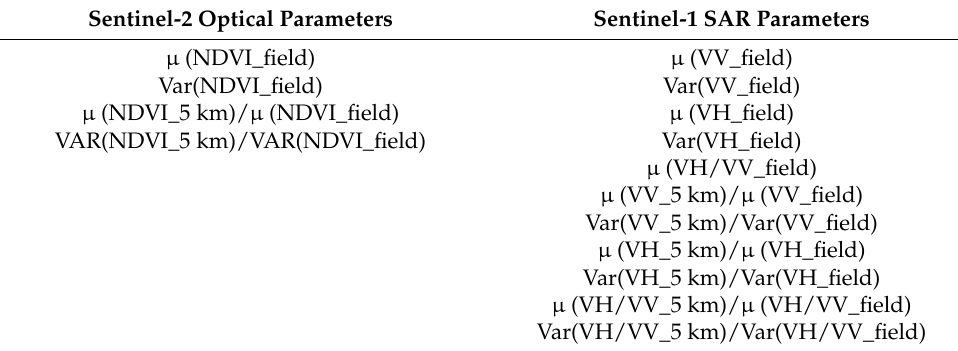
Table 1. Metrics derived from Sentinel-1 and Sentinel-2 image time